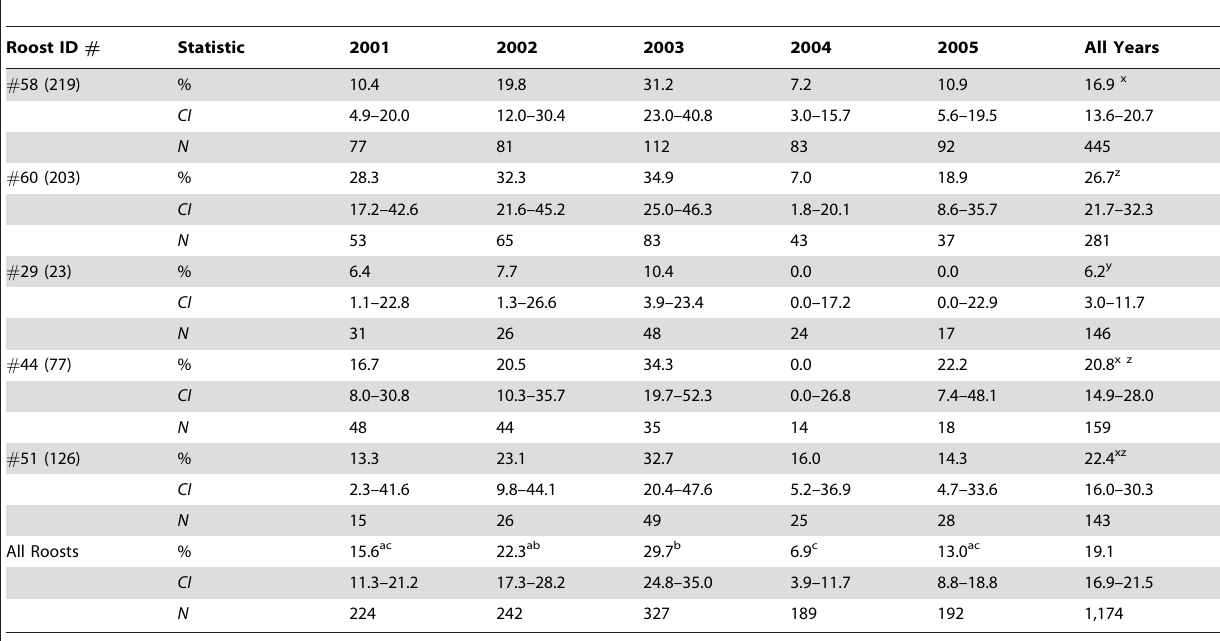
Proportions with superscripts in common for roosts within the right-hand column or for years across the bottom row are not significantly different (P . 0.05). CI= 95% confidence interval for proportion, %=per cent seropositive, N =sample size. Maximum count of adults as a measure of relative colony size (see Methods) is given in parentheses following roost identifiers. Seroprevalence by roost across all years is given in the right hand column, and by year across all roosts in the bottom row, with seroprevalence across all roosts and years provided in the lower right